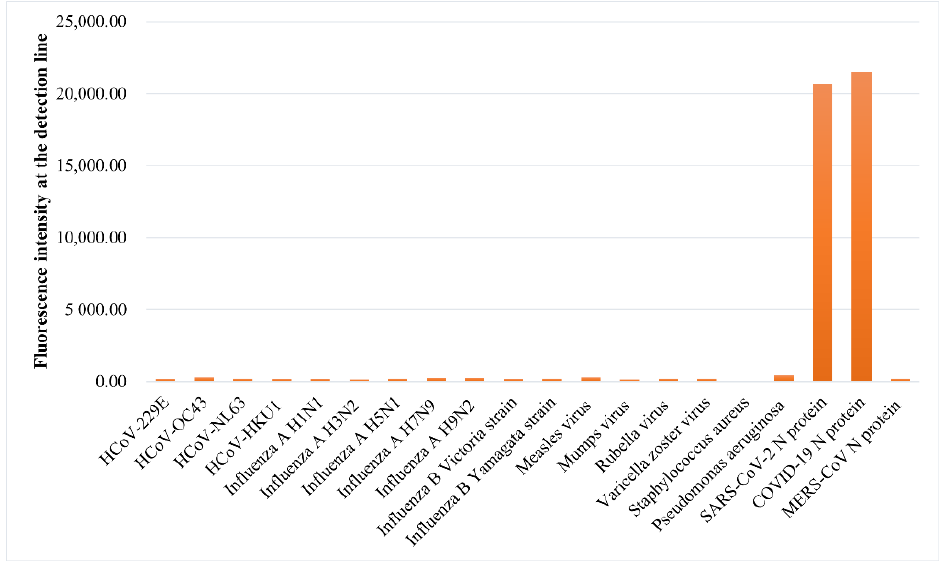
Figure 7. Specificity test results of COVID-19 N protein LFIA strips.